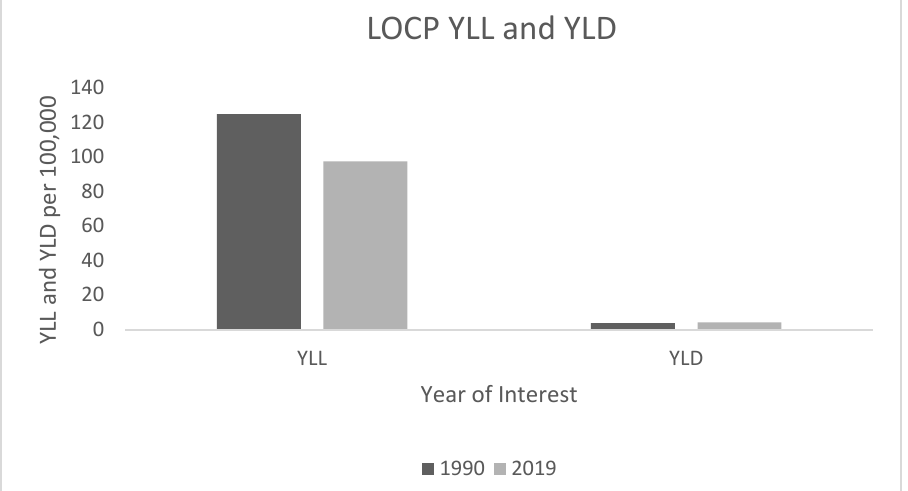
Figure 3. LOCP YLL and YLD trends in 1990 and 2019. YLL: years of life lost; YLD: years lived with